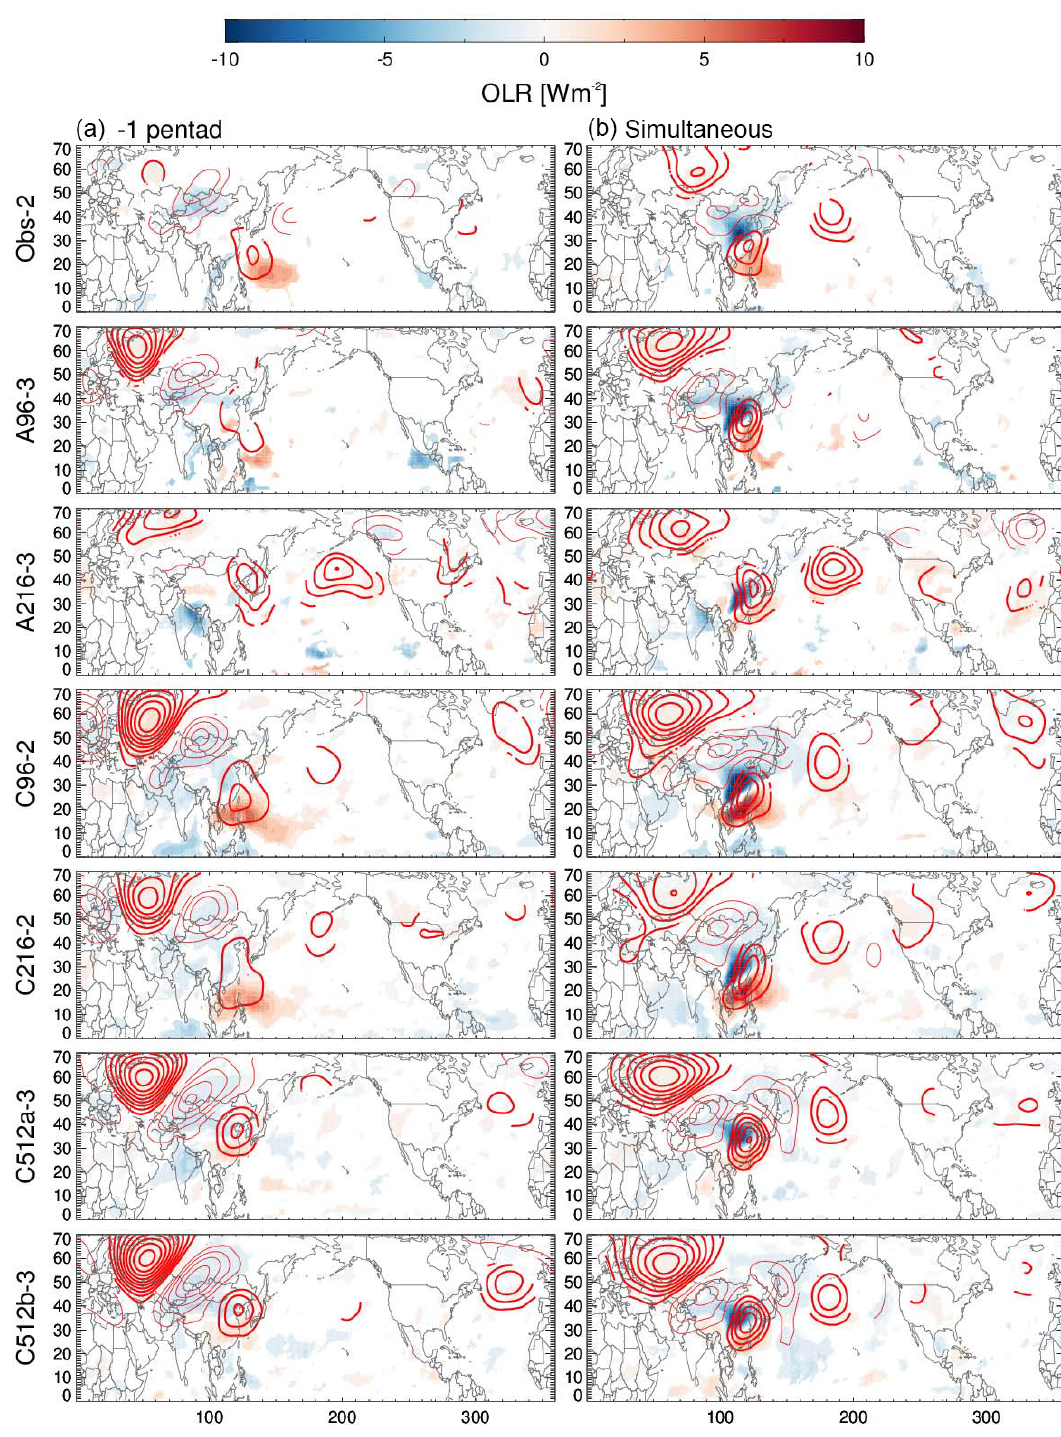
Figure 10. Regression maps of OLR (shading) and Z 500 (thick contours: positive, thin contours: negative, intervals of 0.3m(mmday − 1 ) − 1 against MJJASO EOT time series associated with Obs-2 at lead times of 1 (a) and 0 (simultaneous) pentads. All values shown are significant at the 10%